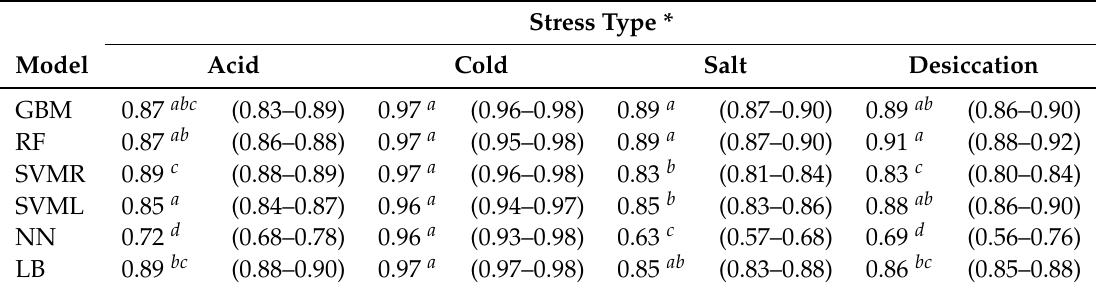
Table 3. Machine learning model performance for prediction of L. monocytogenes stress response